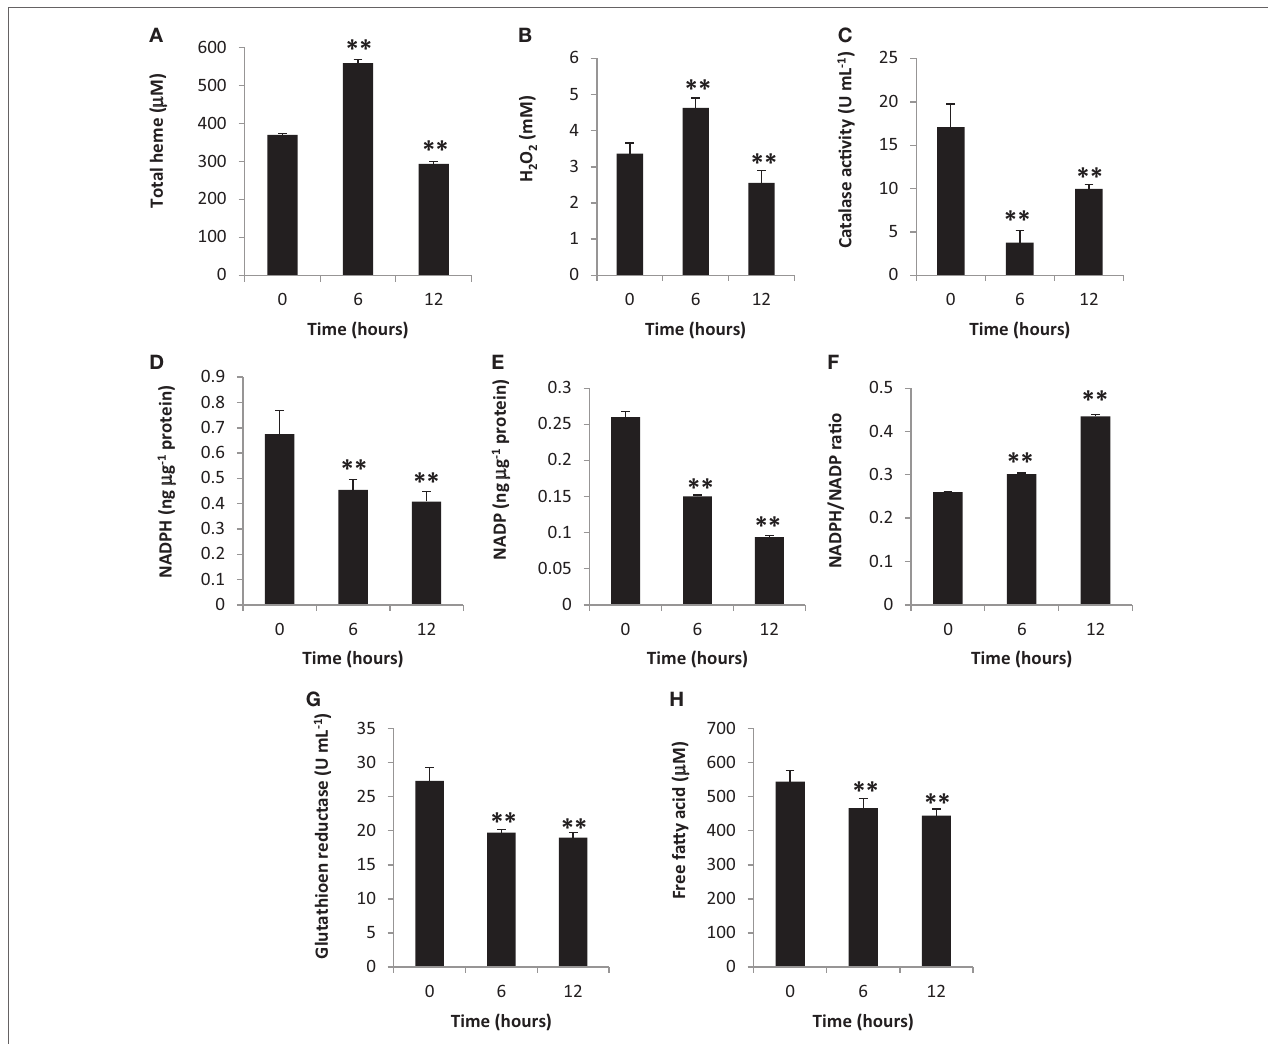
FigUre 1 | Gingival periodontal disease level-butyric acid (BA) induces blood cytosolic oxidative stress. Quantification of blood cytosolic (a) total heme, (B) H 2 O 2 , (c) catalase, (D) NADPH, (e) NADP, (F) NADPH/NADP ratio, (g) free fatty acid, and (h) glutathione reductase amounts are indicated. Results shown are mean ± SE utilizing independent blood samples (collected at 0, 6, and 12 h post-treatment with BA) of 10-week-old Wistar male rats ( n = 6). Statistical analyses were performed using Anderson–Darling normality test and, if passed ( p > 0.05), Student’s t -test (** p < 0.01).